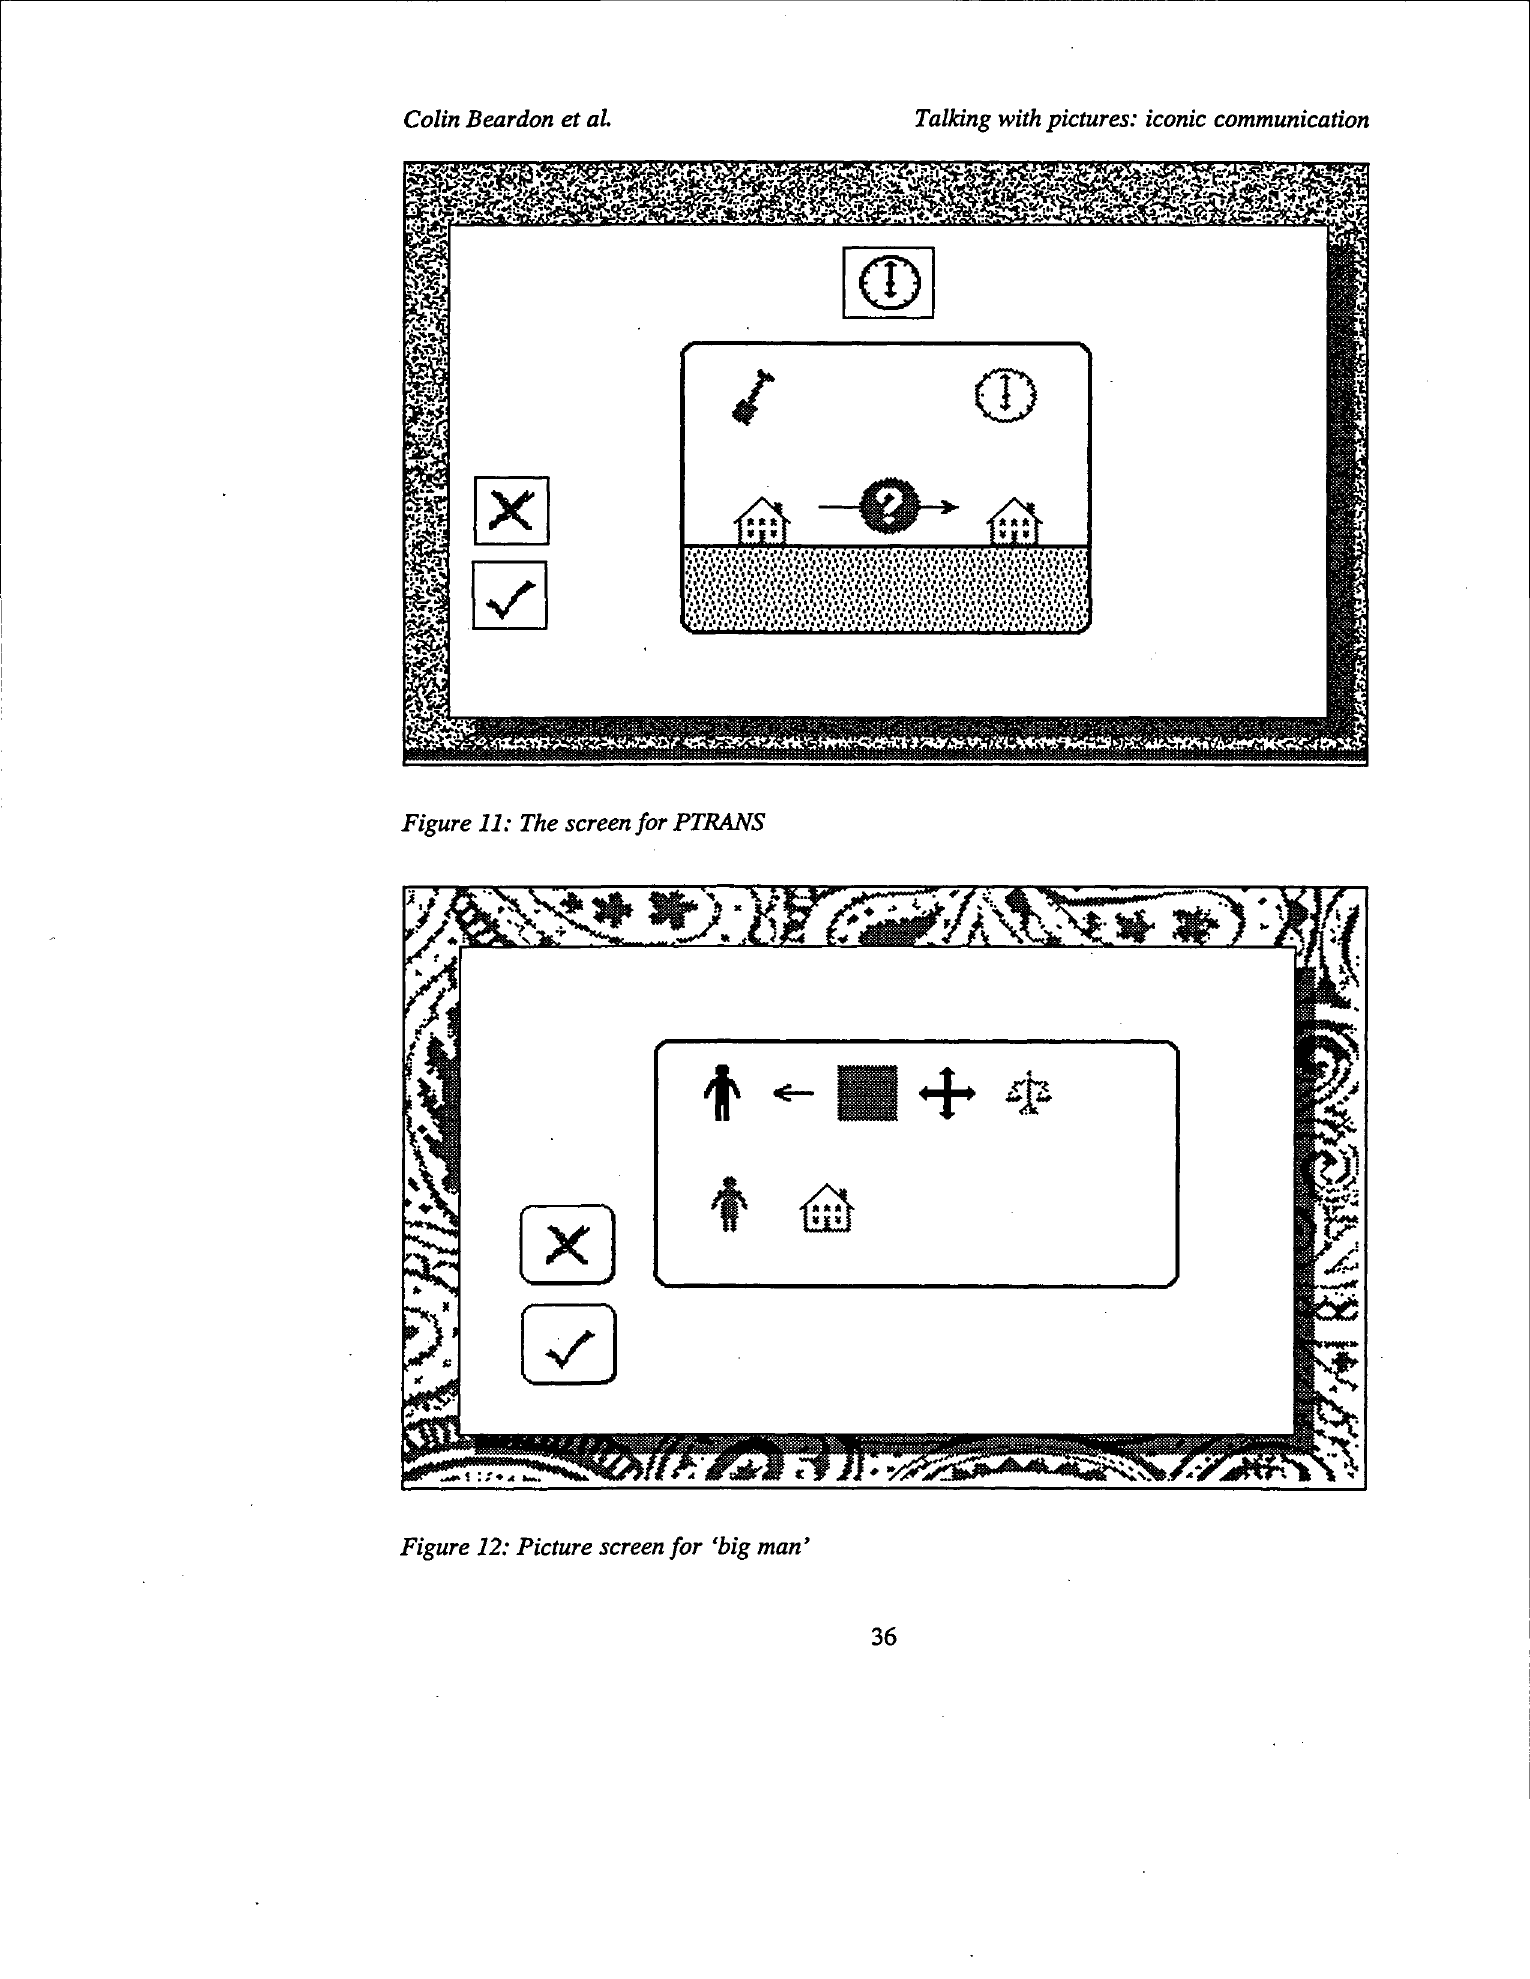
Figure 12: Picture screen for 'big